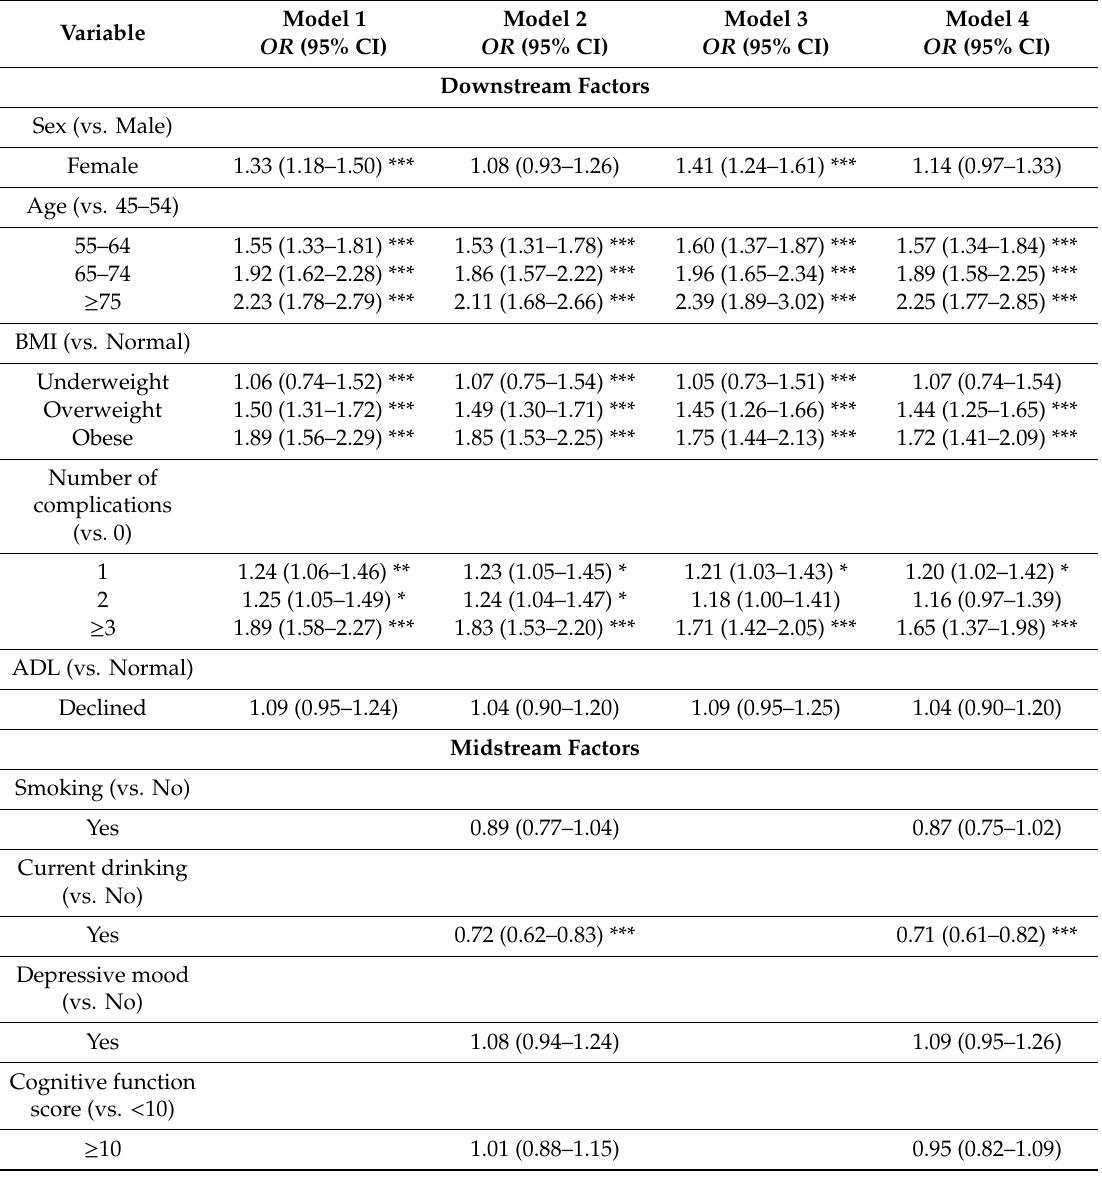
Table 2. Multi-factor logistic regression models for medication